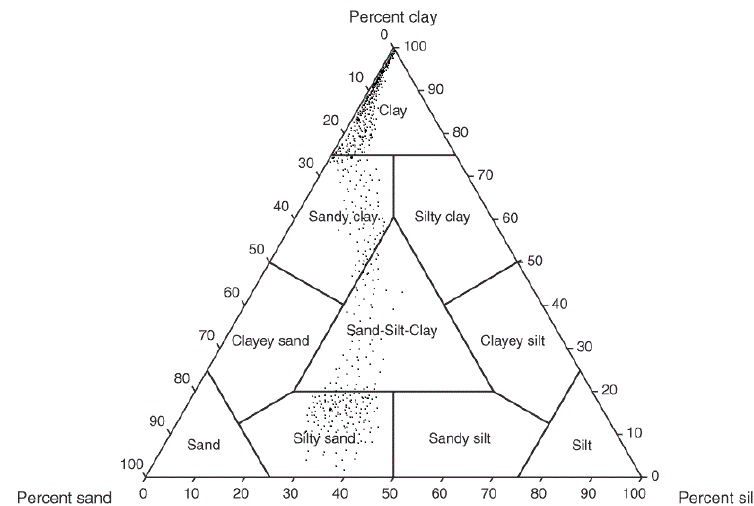
Figure 3. Shepard sediment classification system [51].